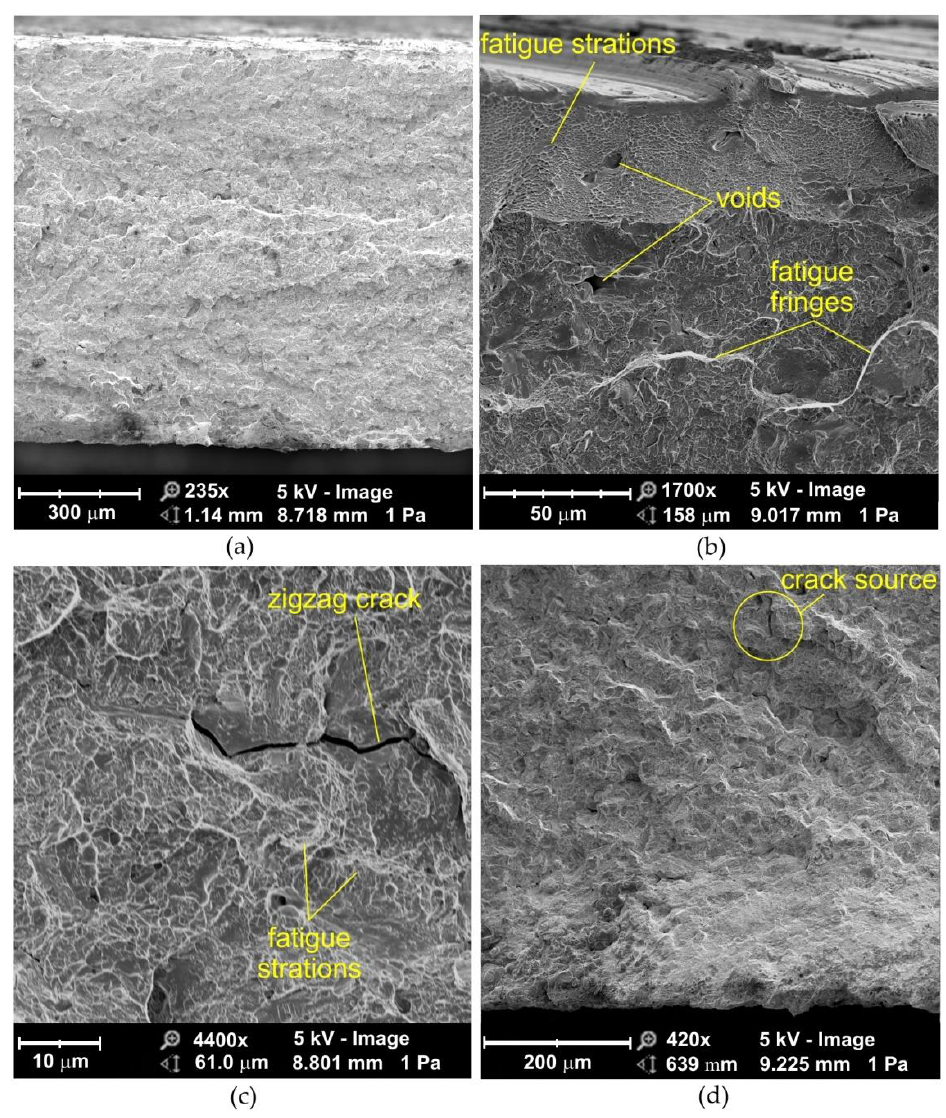
Figure 6. SEM micrographs of the fracture surface of non-sandblasted flash butt welded joints tested at a stress amplitude of 690 MPa: ( a ) cross-section of the fractured surface, ( b ) view of the near-edge layer of the weld, ( c , d ) magnification of the middle area of the weld.